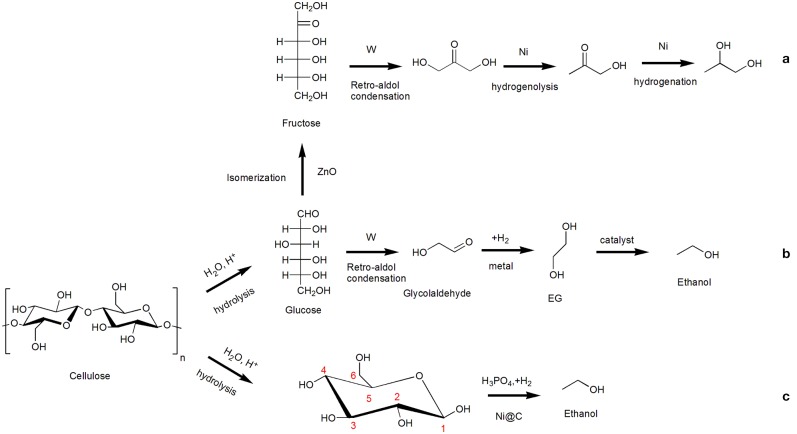
Conversion of cellulose to C2/C3 alcohols.